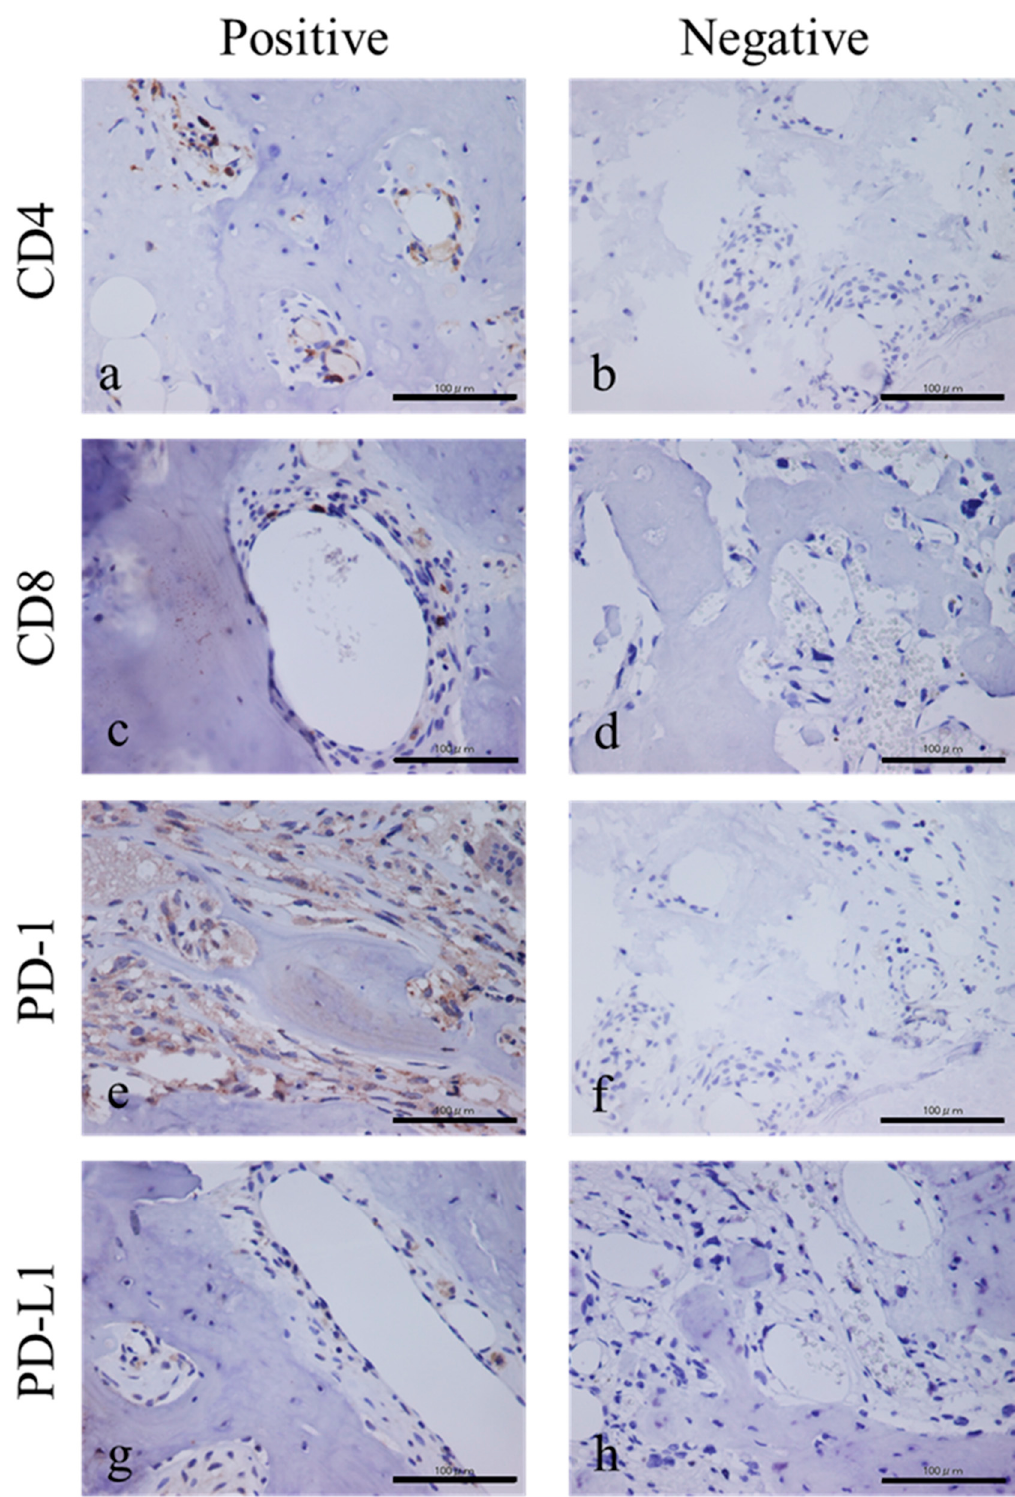
Figure 1. Representative histopathological findings ( a – h ). CD4-positive histological findings ( a ) and CD4-negative findings ( b ). CD8-positive histological findings ( c ) and CD8-negative findings ( d ). PD-1-positive histological findings ( e ) and PD-1-negative findings ( f ). PD-L1-positive histological findings ( g ) and PD-L1 negative findings ( h ).